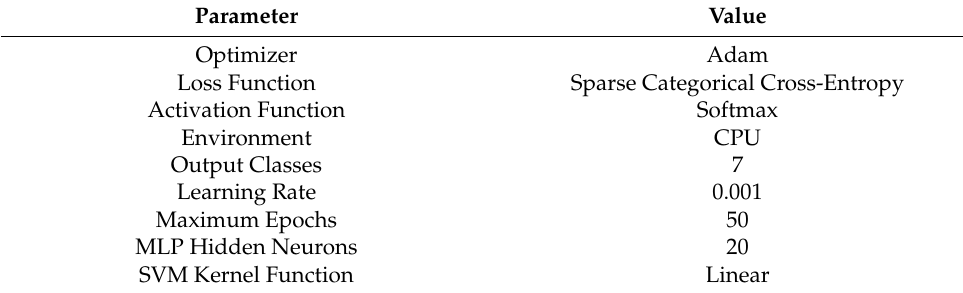
Table 3. Implementation